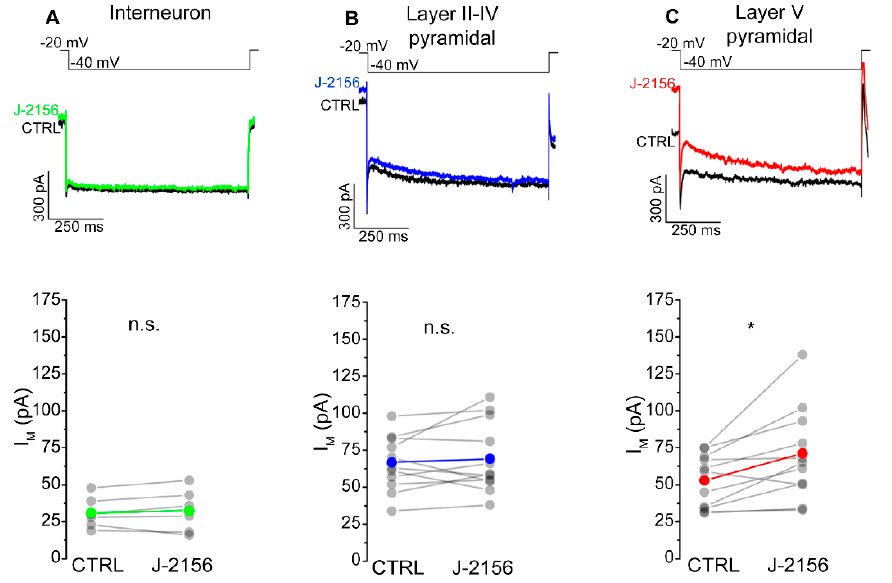
Figure 7. SST 4 receptor activation augments M-current in layer V pyramidal cells of the primary somatosensory cortex (S1). Representative current traces from interneurons ( n = 6, ( A )), somatosensory cortex layer II–IV pyramidal cells ( n = 11, ( B )), layer V pyramidal cells ( n = 11, ( C )), and elicited by the voltage protocol indicated at the top of each panel under control conditions (black) and after bath application of 1 µM J-2156 (colored). M-current was determined as the difference of the instantaneous current at the beginning of the current trace, and the steady current at the end of the current trace. Bottom side: statistics showing M-current amplitude of corresponding cells under control and J-2156 treated conditions. Paired Student’s t -test *: p = 0.016.